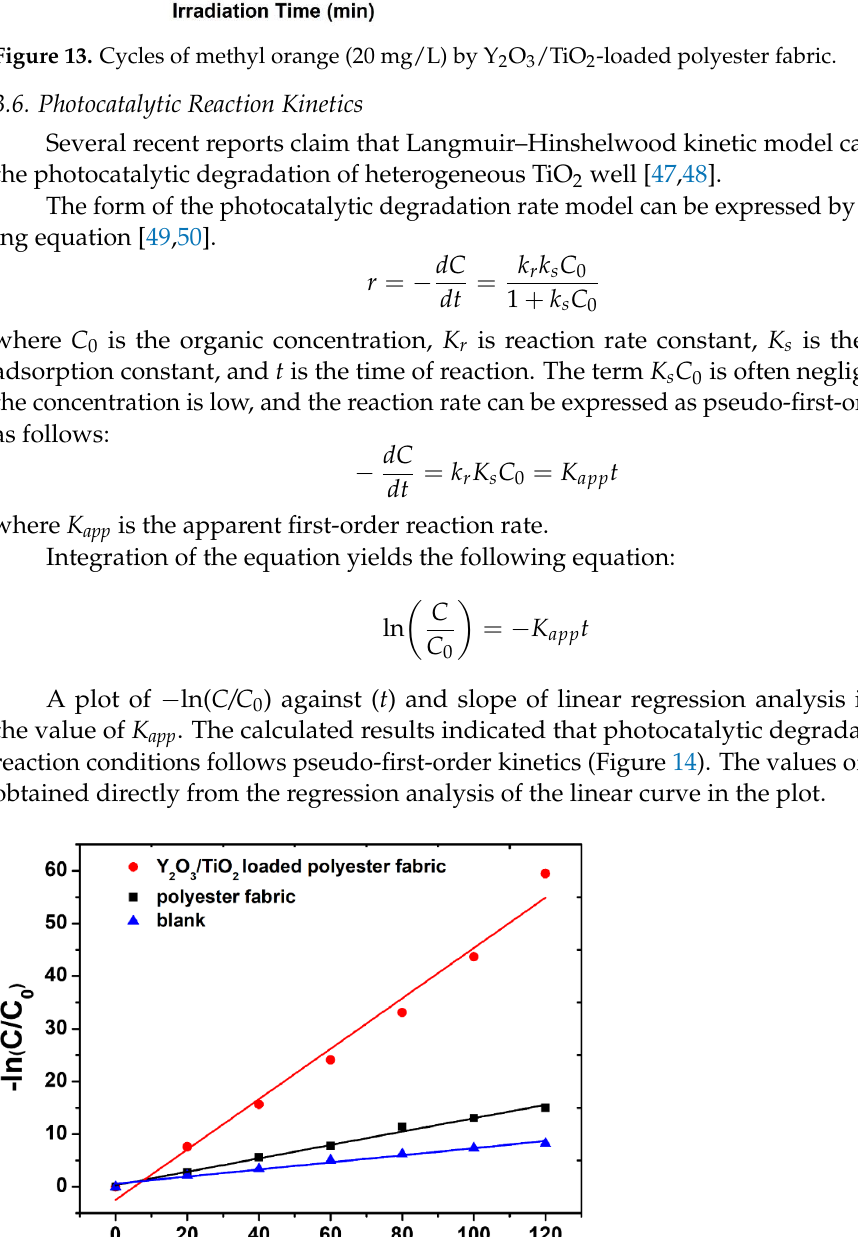
Figure 14. First-order kinetic plot of − ln( C/C 0 ) vs. t .